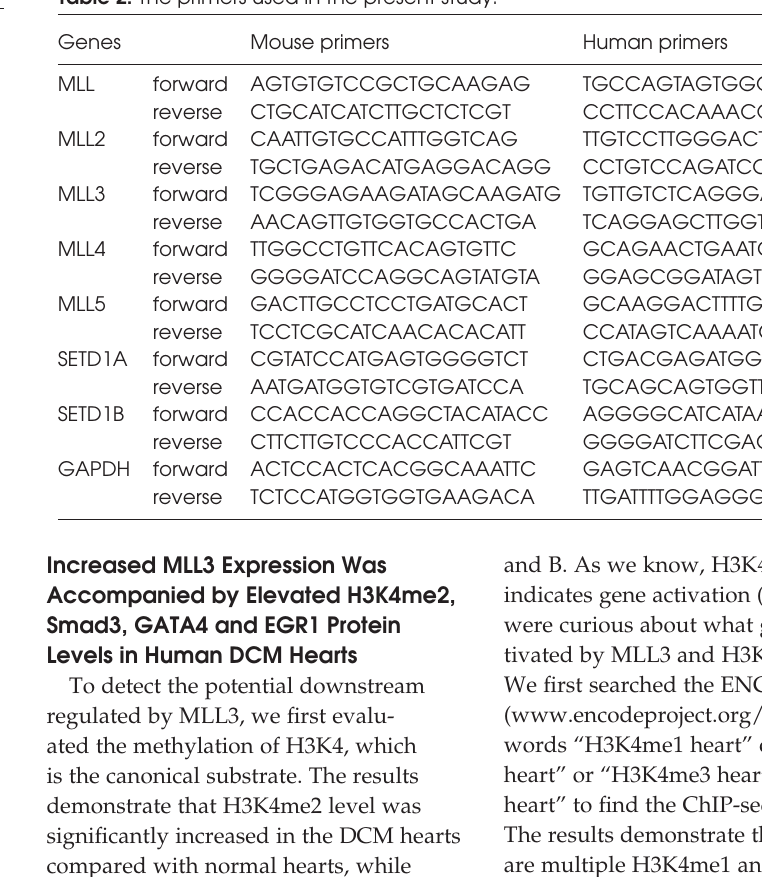
BMI: body mass index; LVEDD: left ventricular end diastolic dimension; LVEF: left ventricular ejection fraction Table 2. The primers used in the present